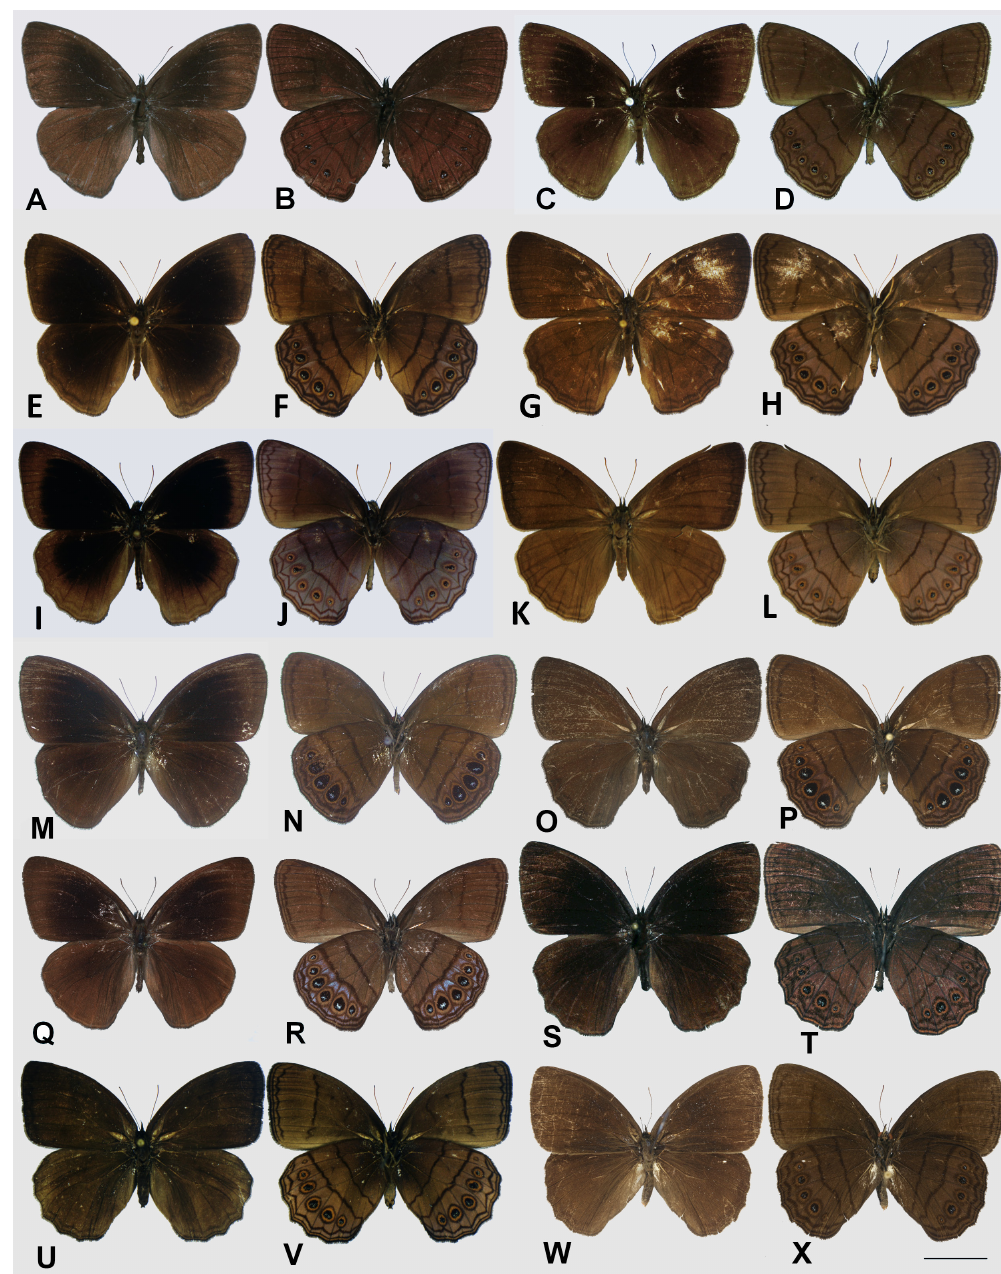
Fig. 2. Zischkaia “ pacarus clade”, wing plate. A –B . Z. amalda (Weymer, 1911), lectotype, ♂, dorsal and ventral views. C–D . Z. arctoa Nakahara, sp. nov., paratype, ♂ (in RFC, collected in 1975), dorsal and ventral views. E–F . Z. chullachaki Nakahara & Zacca, sp. nov., holotype, ♂, dorsal and ventral views. G–H . Z. chullachaki sp. nov., paratype, ♀ (DZ 36. 508), dorsal and ventral views. I–J . Z. baku Zacca, Dolibaina & Dias, sp. nov., holotype, ♂, dorsal and ventral views. K–L . Z. baku sp. nov., paratype, ♀ (DZ 36. 404), dorsal and ventral views. M–N . Z. arenisca Nakahara, Willmott & Hall, sp. nov., holotype, ♂, dorsal and ventral views. O–P . Z. arenisca sp. nov., paratype, ♀ (FLMNH-MGCL 297320), dorsal and ventral views. Q–R . Z. argyrosflecha Nakahara, L. Miller & Huertas, sp. nov., holotype, ♂, dorsal and ventral views. S–T . Z. pacarus (Godart, [1824]), neotype, ♂, dorsal and ventral views. U–V . Z. pacarus , ♀ (DZ 36. 909), dorsal and ventral views. W–X . Z. abanico Nakahara & Petit, sp. nov., holotype, ♂, dorsal and ventral views. Scale bar: 1